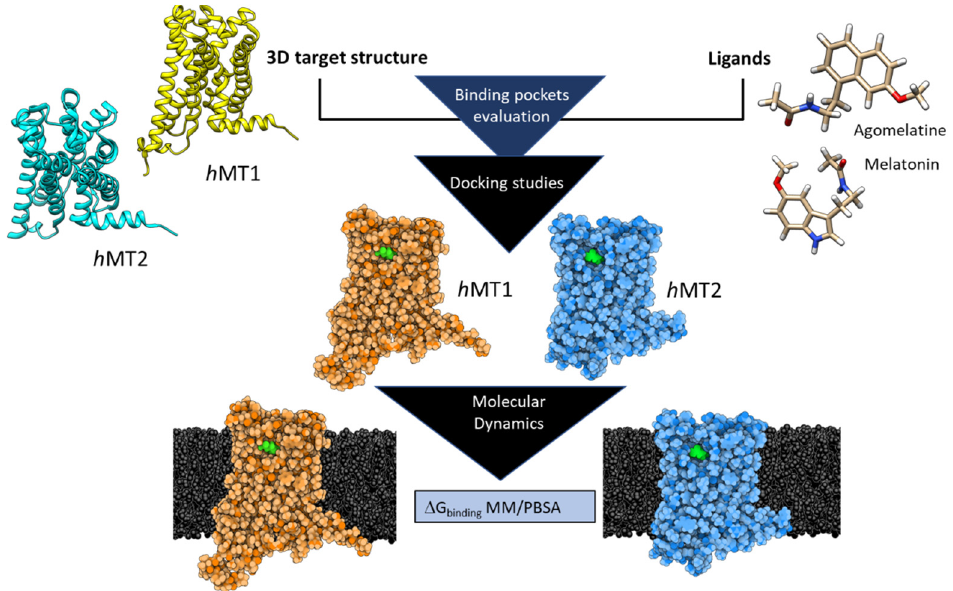
Figure 13. Computational Workflow .